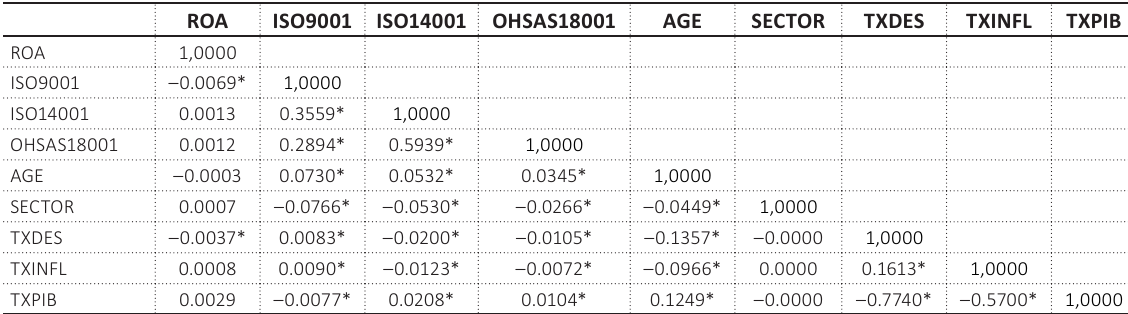
Table 4. Correlation